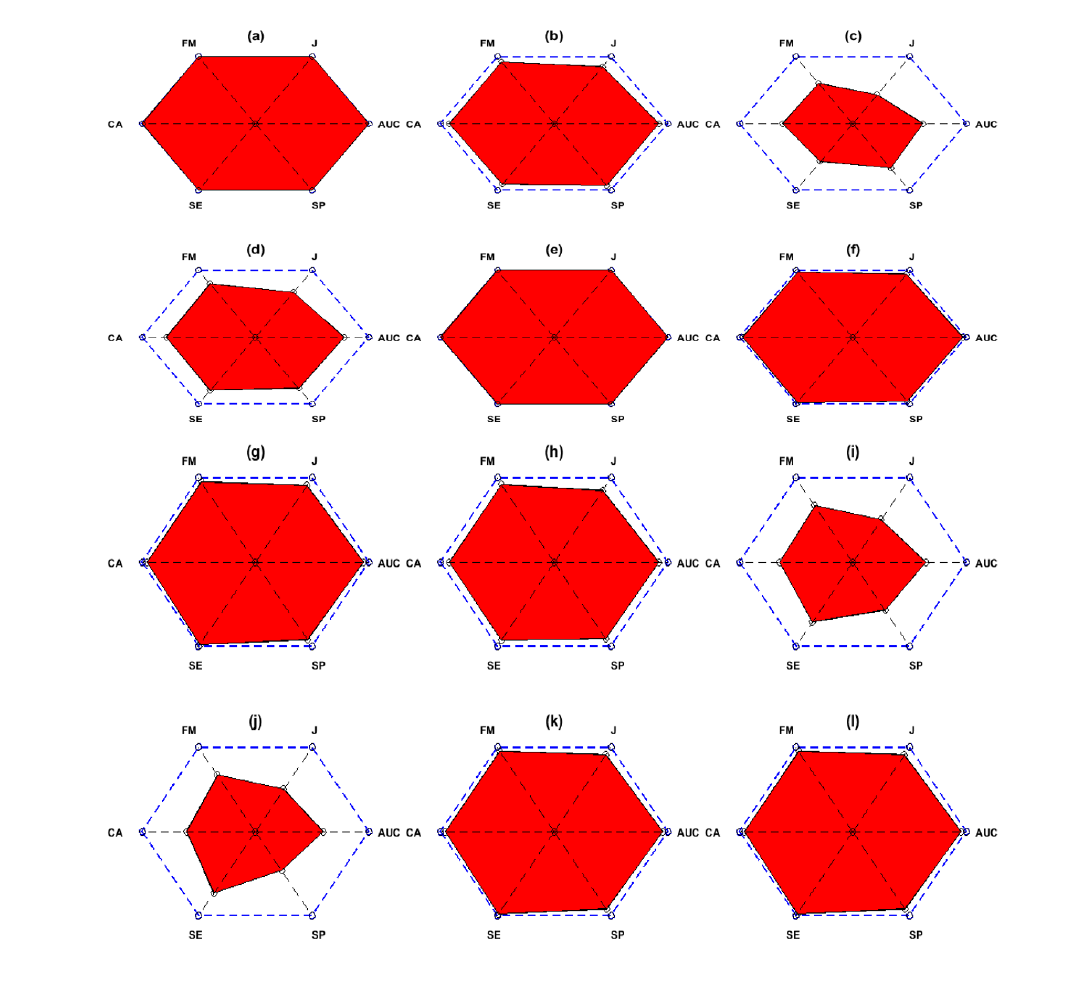
Figure 6. ( a – f ) PAM for Subjects “aa”, “al”, “av”, “aw”, “ay” and “Dataset IVb” respectively using FFNN classifier. ( g – l ) PAM for Subjects “aa”, “al”, “av”, “aw”, “ay” and “Dataset IVb” respectively for SVM